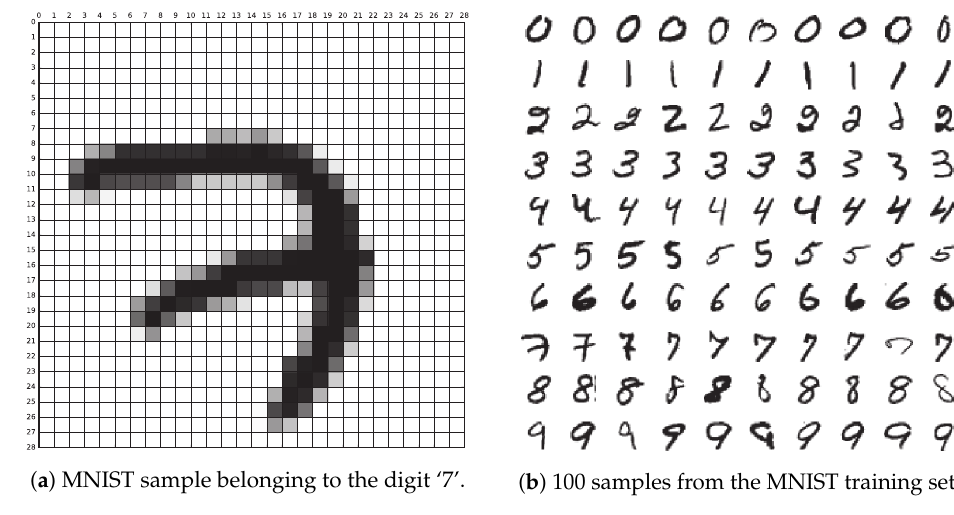
Figure 1. Example of the MNIST